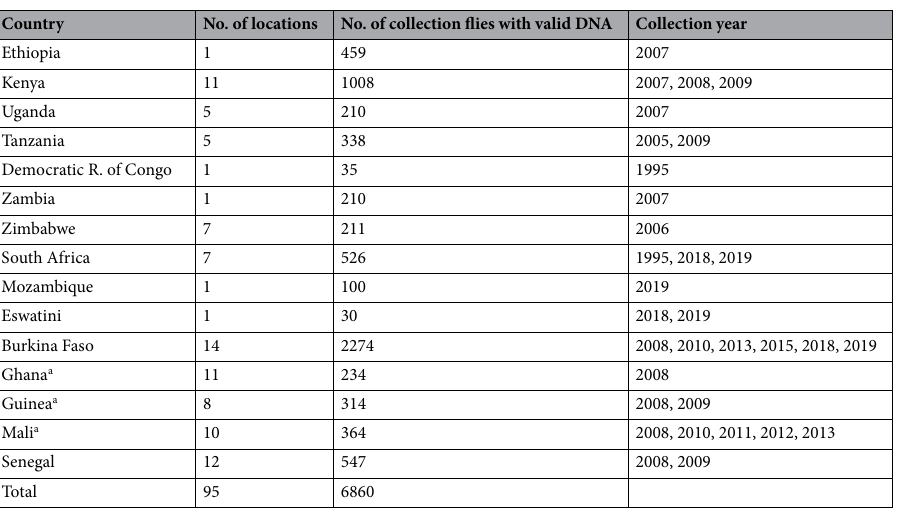
Table 6. List of collections of tsetse adults with valid DNA screened for Sodalis and Trypanosome a infection in wild tsetse population in east, central, southern and west Africa. a Part of the trypanosome infection in west Africa was screened by Ouedraogo et al .